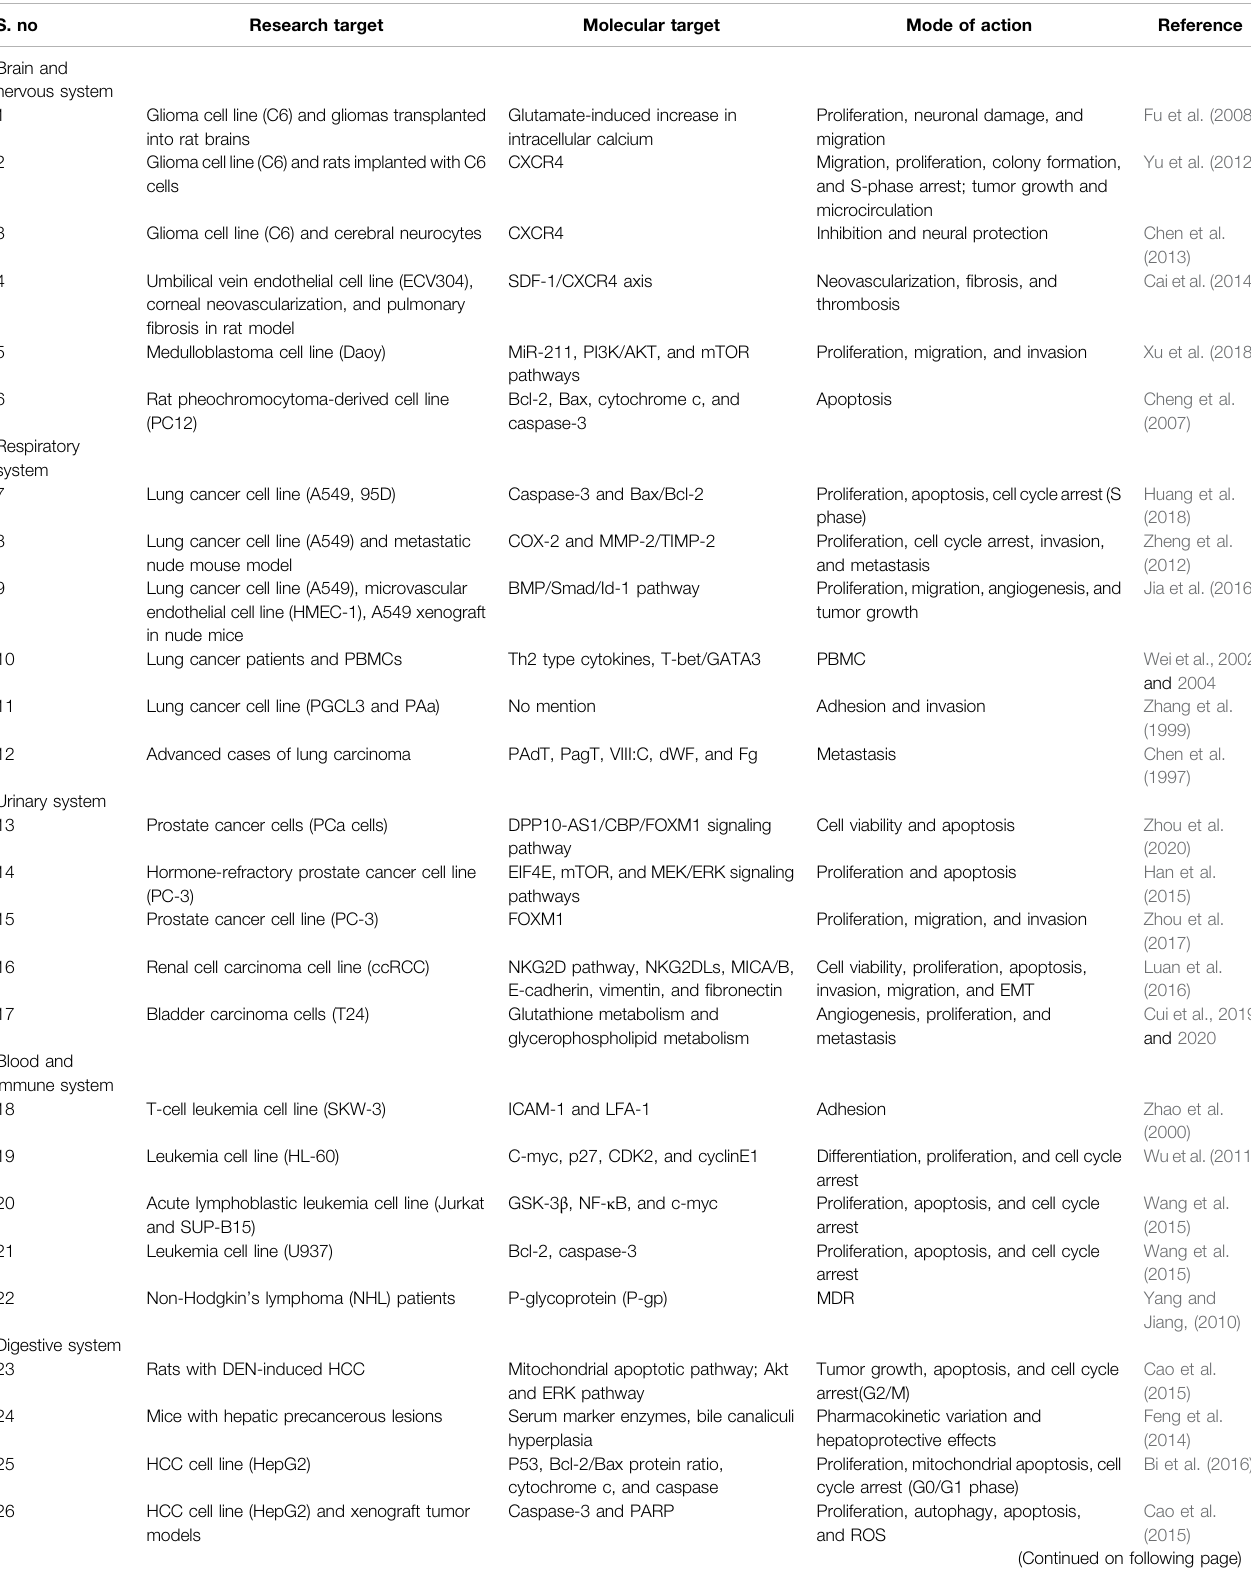
TABLE 2 | Antitumor effect of tetramethylpyrazine against the tumor models of multiple organs. S.